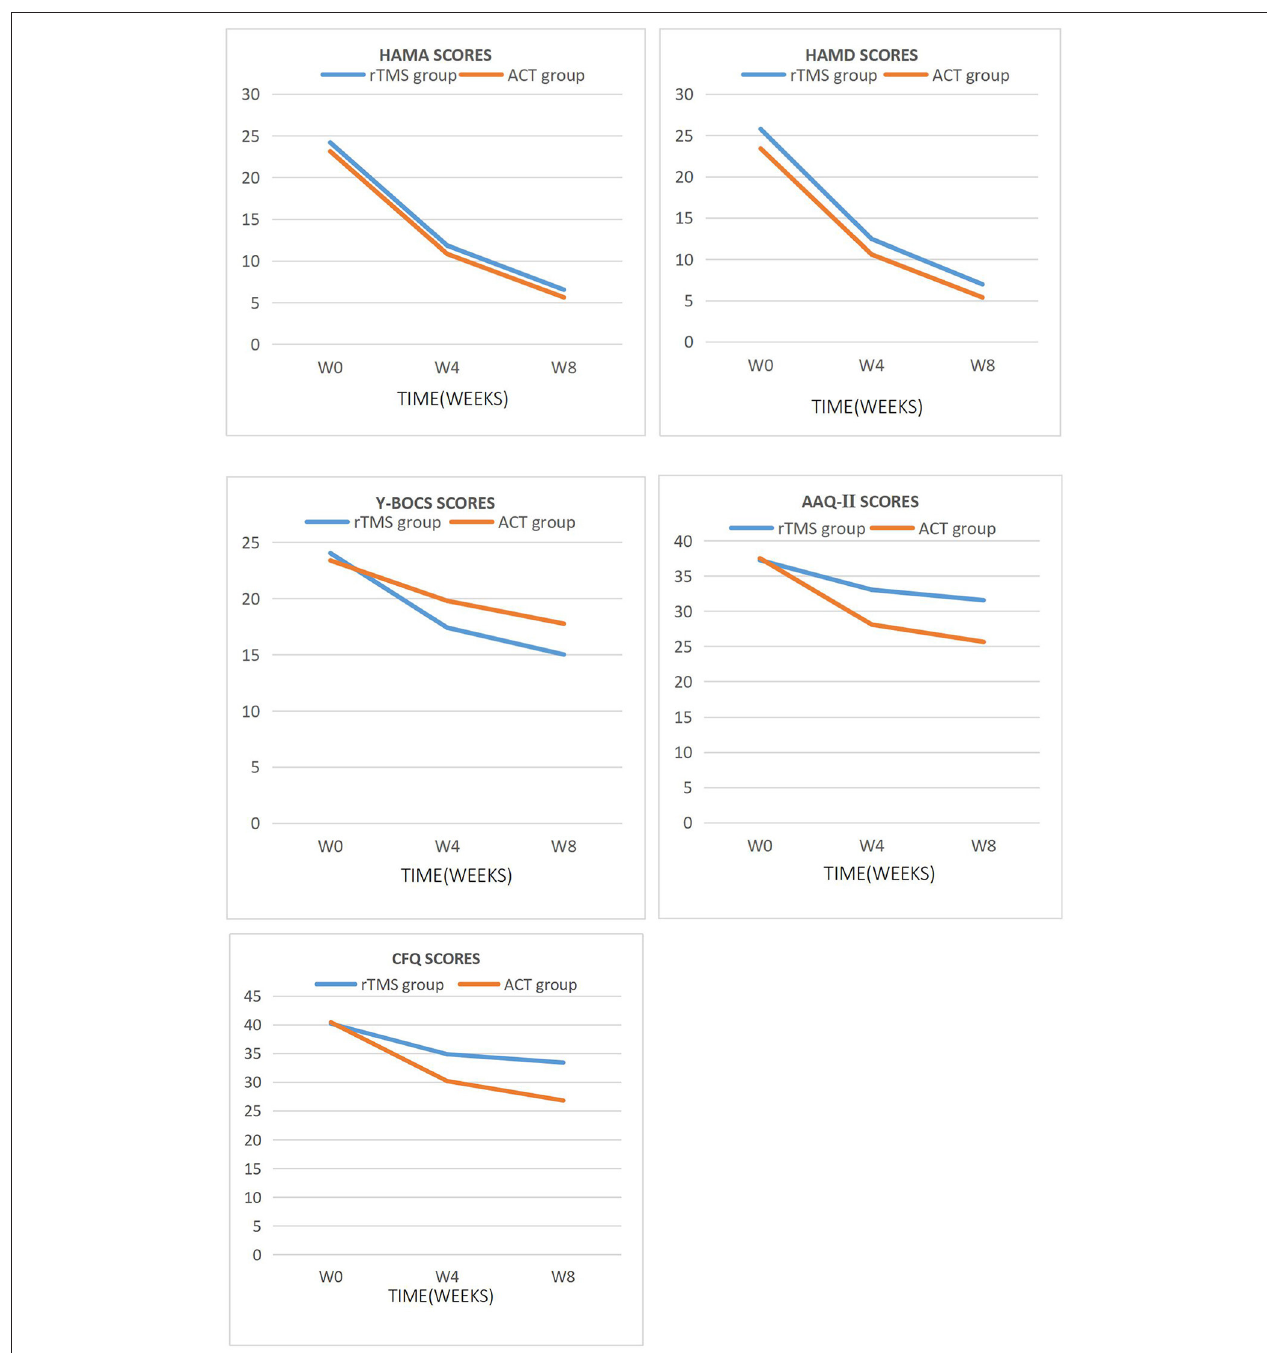
FIGURE 2 | Main effect of time was observed for HAMA, HAMD, Y-BOCS, AAQ-II, and CFQ scores.